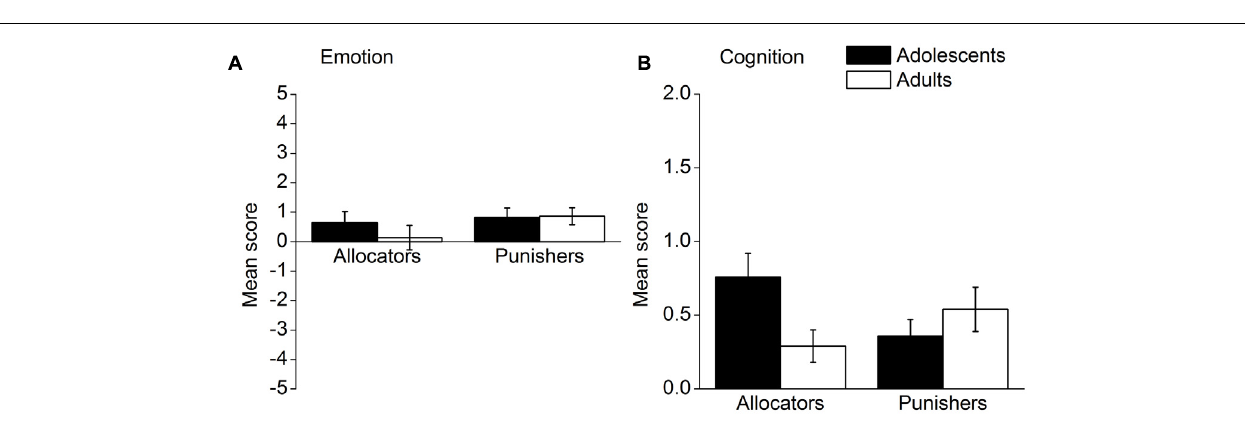
FIGURE 4 | Mean emotion and cognitive scores by role and age group; (A) mean emotion scores, (B) mean fairness scores. Error bars represent standard